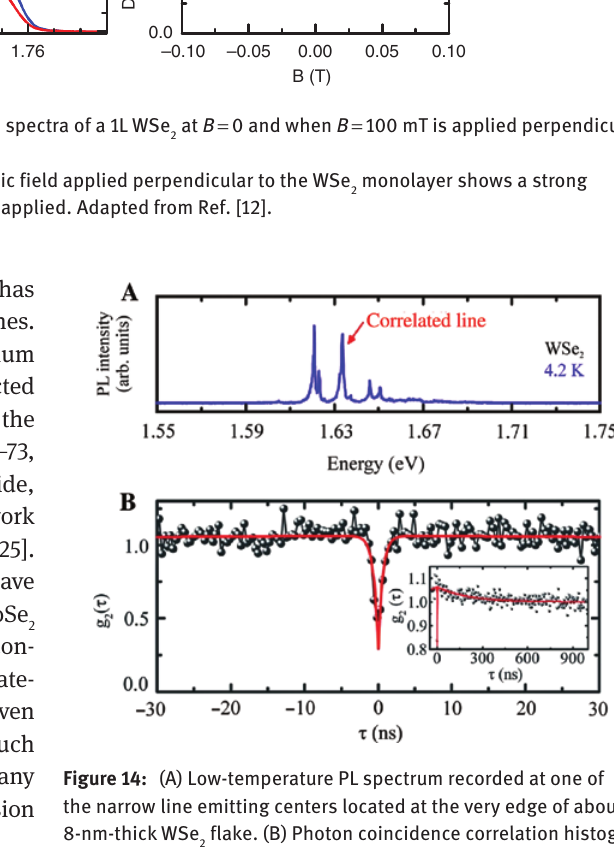
Figure 14: (A) Low-temperature PL spectrum recorded at one of the narrow line emitting centers located at the very edge of about 8-nm-thick WSe flake. (B) Photon coincidence correlation histogram 2 displaying a second-order autocorrelation function g ( τ ), where τ 2 denotes the time interval between the coincidence counts, meas- ured for the narrow emission line marked in (A) with a red arrow. Figure adapted from Ref.